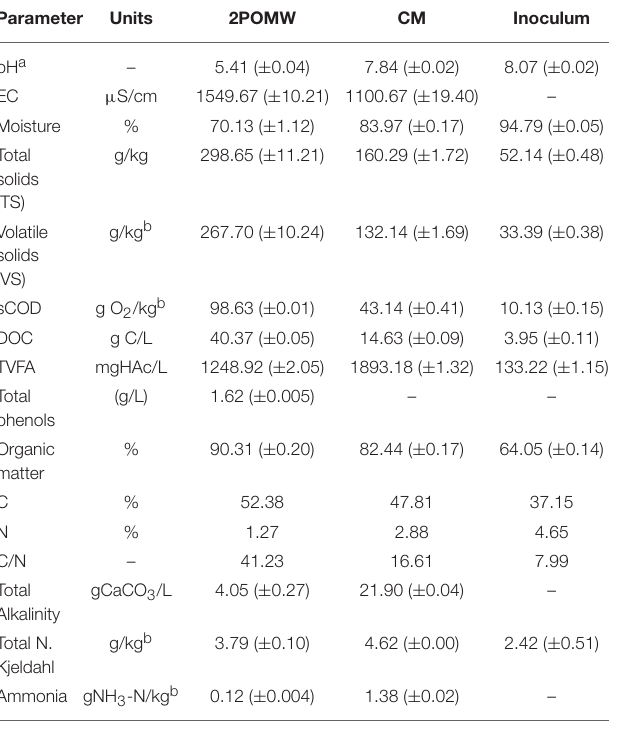
TABLE 1 | Characteristics of the wastes used (2POMW and CM) and the inoculum. Parameter